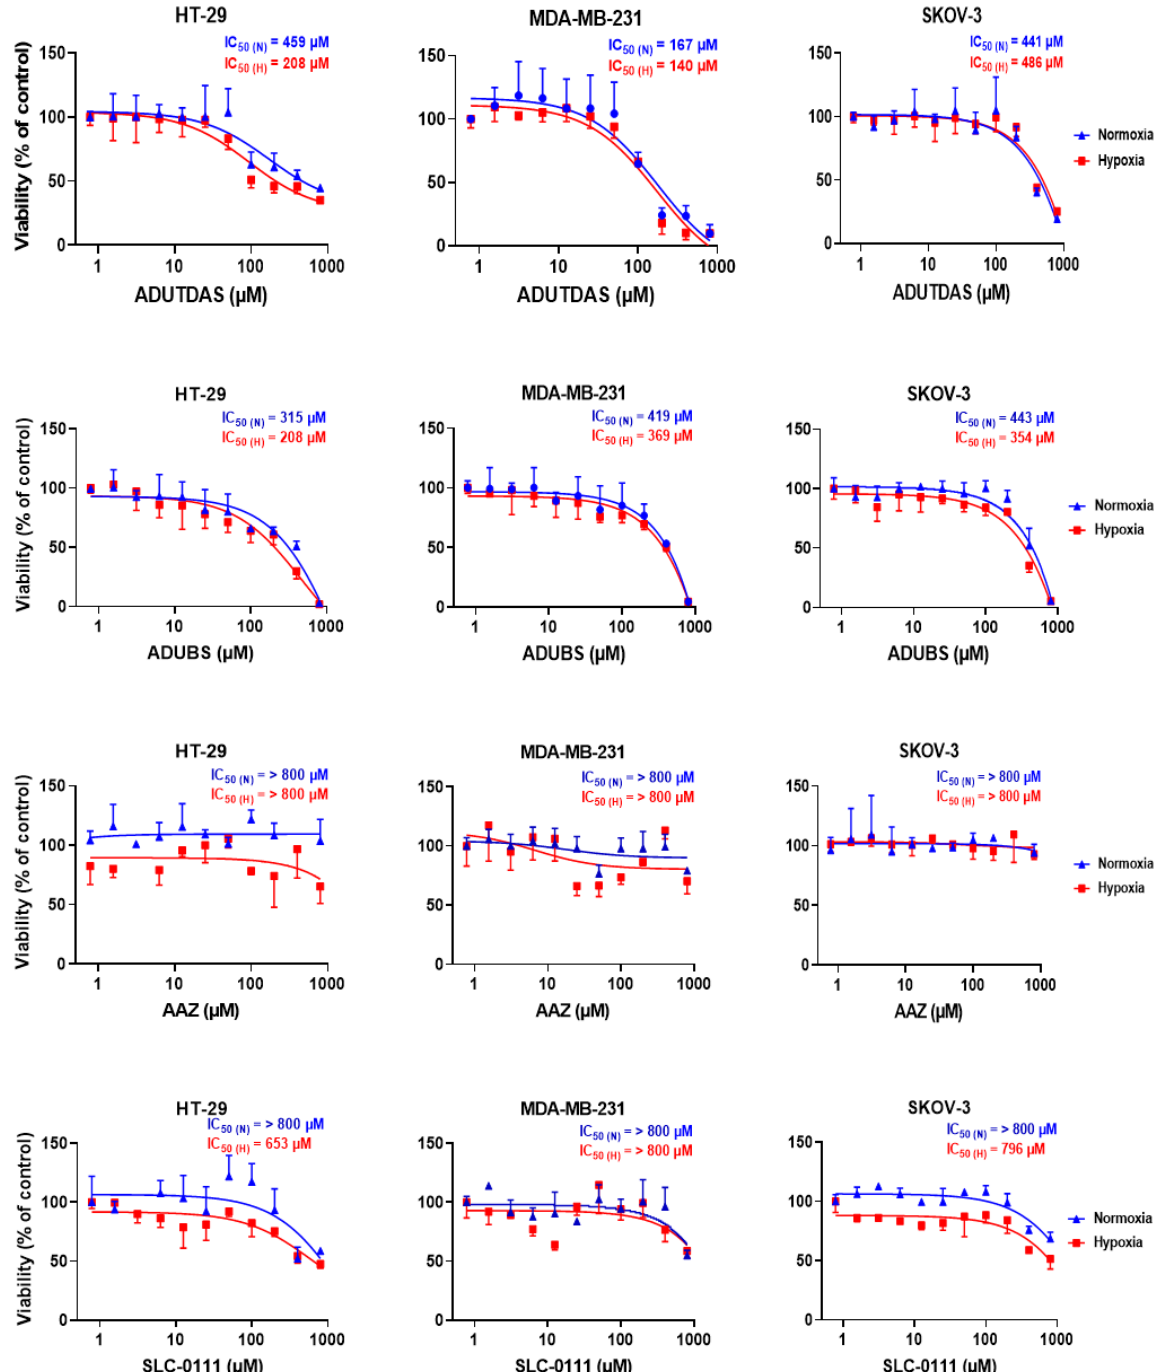
Figure 5. Viability of HT-29, MDA-MB-231 and SKOV-3 cells upon treatment with CAIs ADUTDAS, ADUBS, AAZ and SLC-0111 under normoxia (blue curves) and hypoxia (red curves). The IC 50 values determined for each inhibitor were indicated.